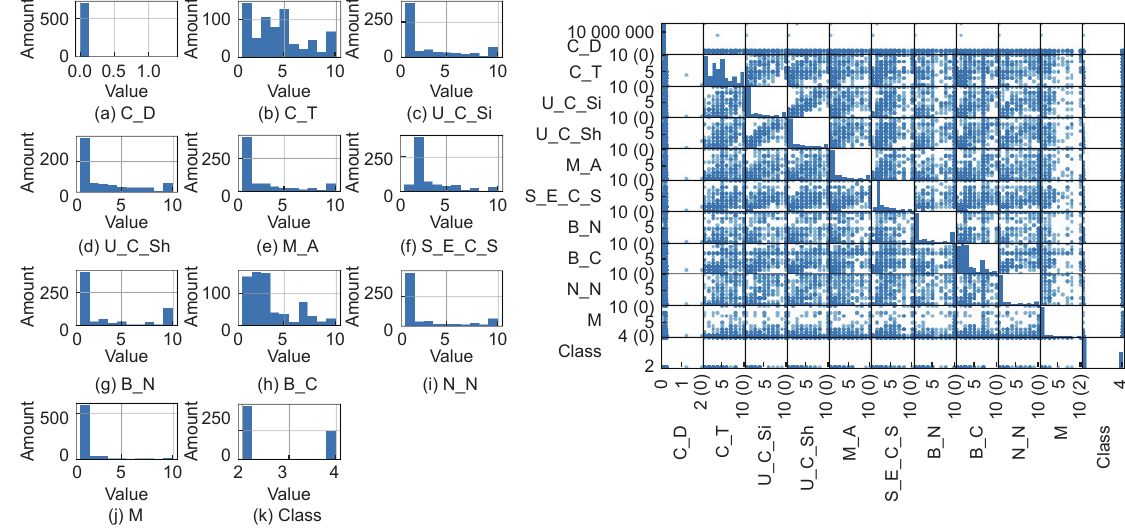
Fig. 5 Data serial numbers 2−10 in Table 1, and the last value represents the stage of the cancer cell. When it undergoes the specific process of differentiating into various cancer cell stages after the judgment of , the output function finally outputs the probability of the tumor type (2: benign, 4: malignant). Then, we used CPNTools [25] for model simulation.